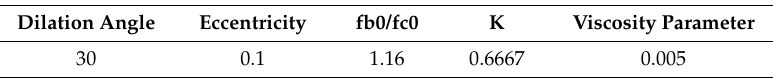
Figure 14. Constitutive relationship of materials. ( a ) steel and rebar; ( b ) compression of concrete; and ( c ) tension of concrete. Table 7. Parameters of